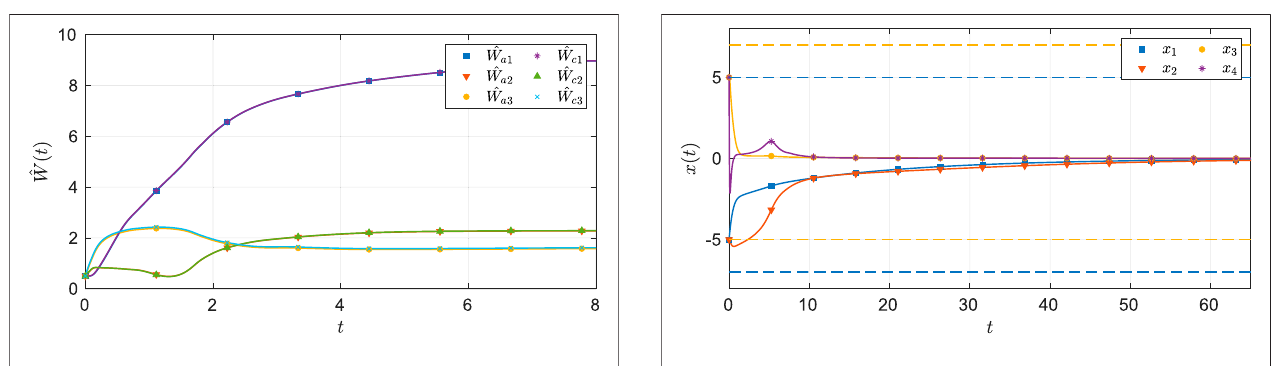
FIGURE 3 | Estimates of the actor and the critic weights under nominal gains for the two-state dynamical system.